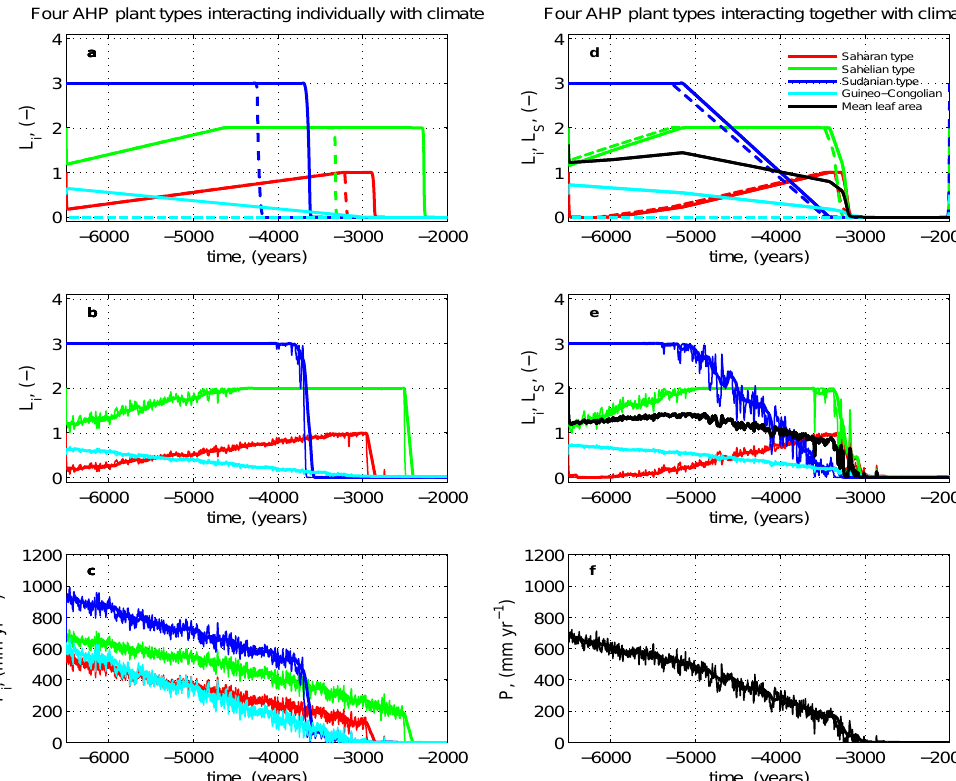
Figure 3. Transient dynamics of four African Humid Period (AHP) plant types interacting individually (a–c) and together (d–f) with climate. The effective leaf areas L i and the corresponding precipitation amounts P i are shown for the Saharan type (red), Sahelian type (green), Sudanian type (blue), and Guineo–Congolian type (light blue). Mean effective leaf area L S and the corresponding precipitation P are calculated with the niche approach (black) (see Eq. 9). Simulations without background noise (a, e) include forward simulations (solid lines) and simulations backward in time (dashed lines). Simulations with background noise are depicted in (b, e) for L i and L S , and for precipitation P in (c, f) . Thin lines show annual mean values and thick lines show a 100 year running mean.